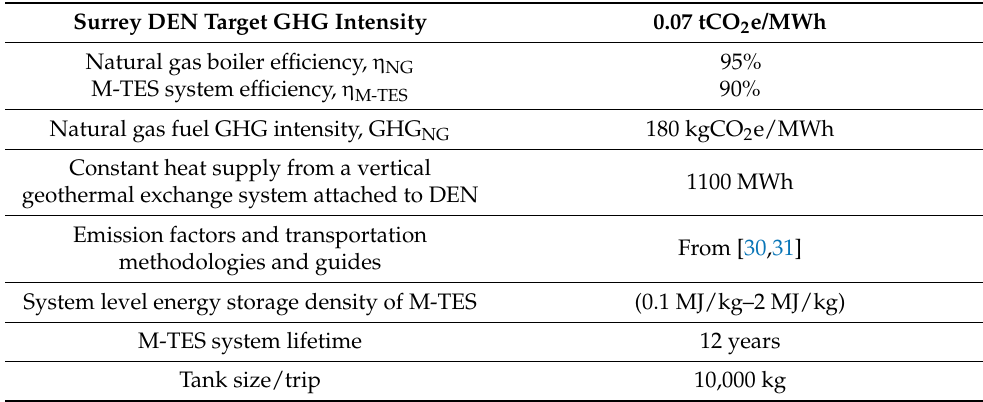
Table 3. The assumptions used in the analysis.